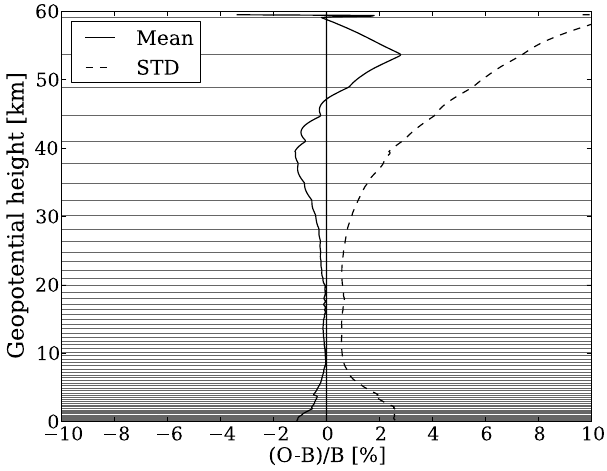
Figure 3. Bending angle innovations from the same period as Fig. 2, with typical model levels overlaid. The functional form of refractiv- ity used in the Abel integral is Eq. (2). Note that the model levels are plotted on geopotential heights and not converted to impact